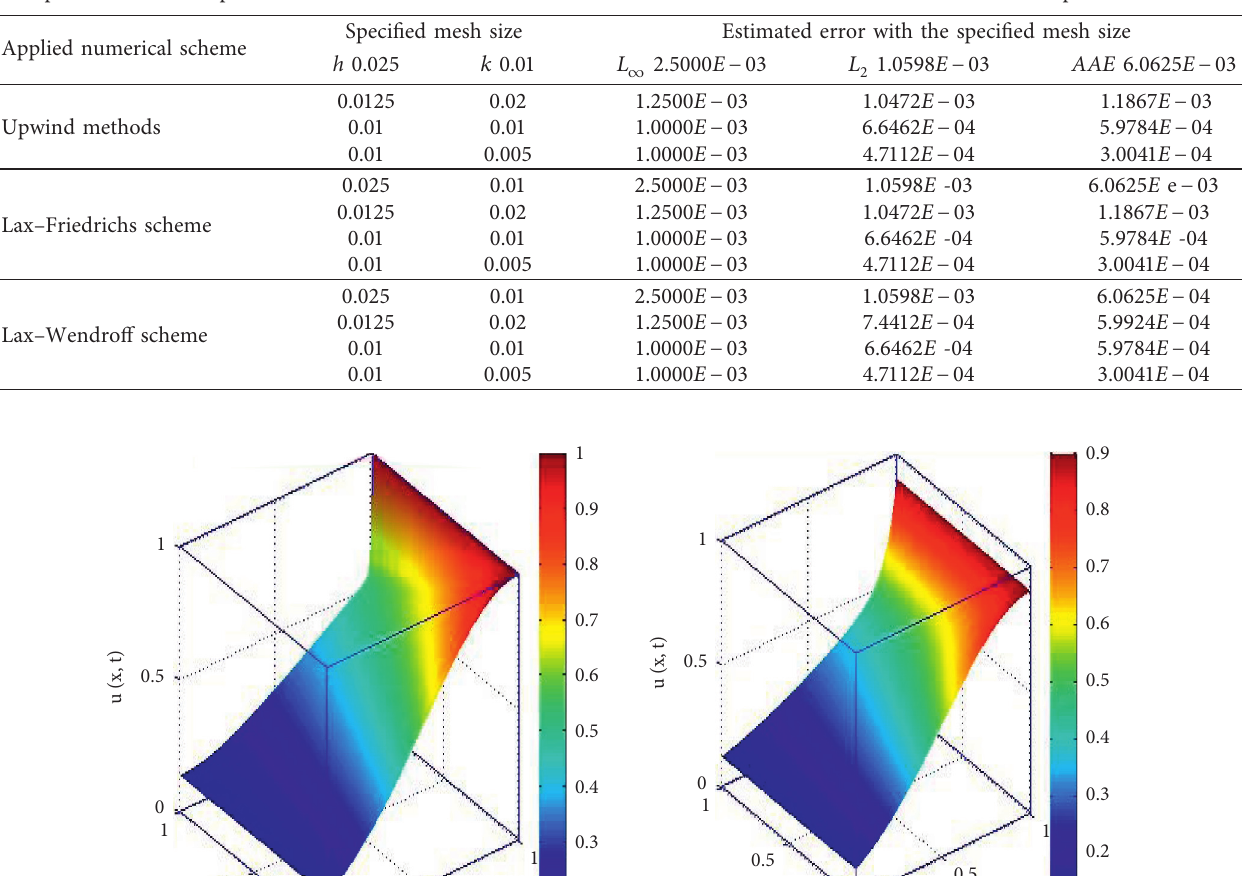
Table 3: Comparison of point average absolute error, root mean square error, and pointwise maximum absolute error for problem given in